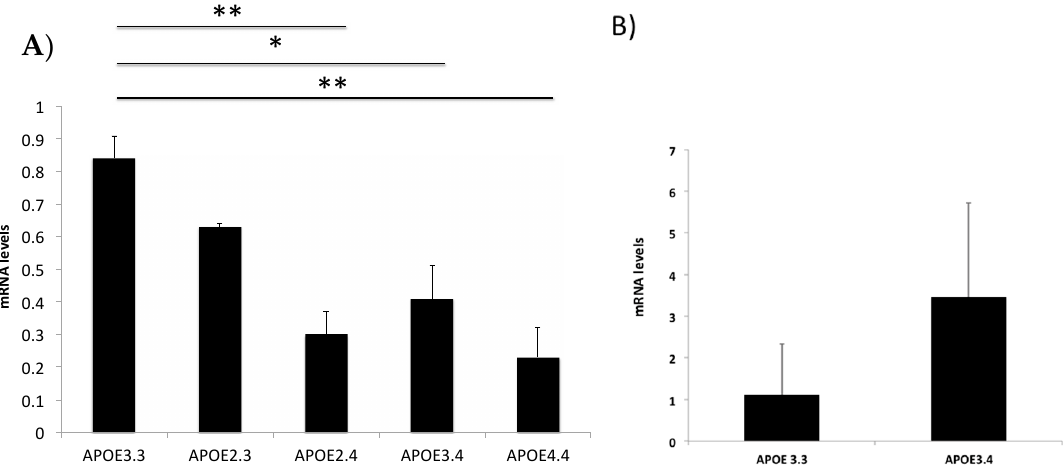
Figure 3. Gene expression in patients with different APOE genotypes. ( A ) APOE gene expression was analyzed in buffy coat samples from patients with the APOE 3.3 , APOE 2.3 , APOE 2.4 , APOE 3.4 and APOE 4.4 genotypes, and in ( B ) healthy individuals with the APOE 3.3 and APOE 3.4 geno- types. Data are presented as means ± S.E.M. One-way ANOVA with Bonferroni corrections or t stu- dent (* p < 0.05; ** p < 0.01).